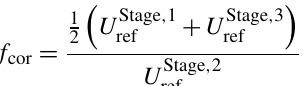
tered for a wind direction from the fjord, we expect that the ambient turbulence intensity is lower than 20 % and that a f cor based on a turbulence intensity of 10 % is